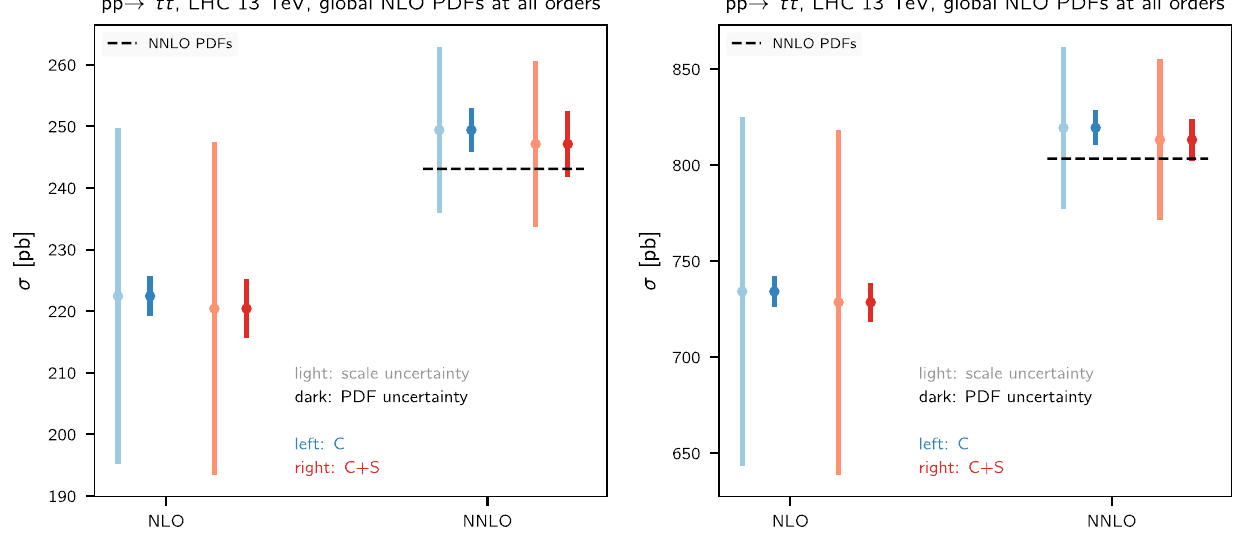
Fig. 22 Same as Fig. 21 for top-quark pair production at 8 and 13 TeV, see also Table